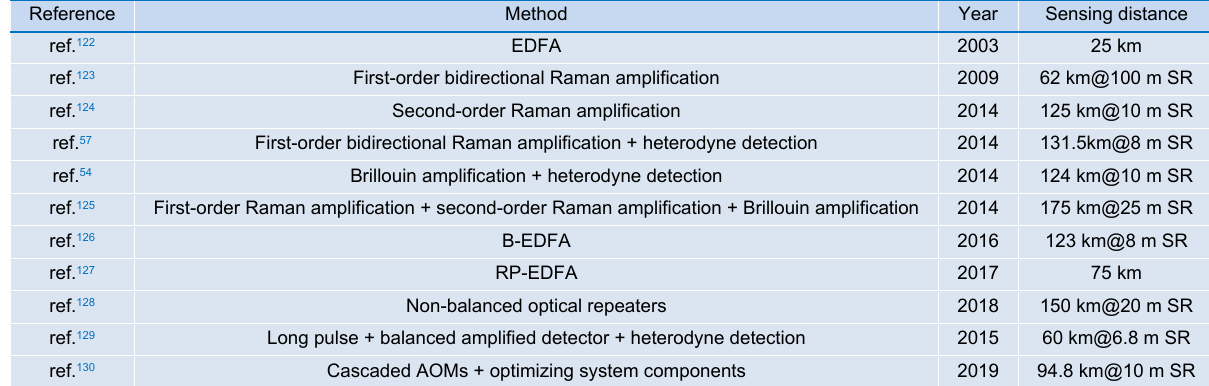
Table 1 | Research progress on improving sensing distance in Ф-OTDR